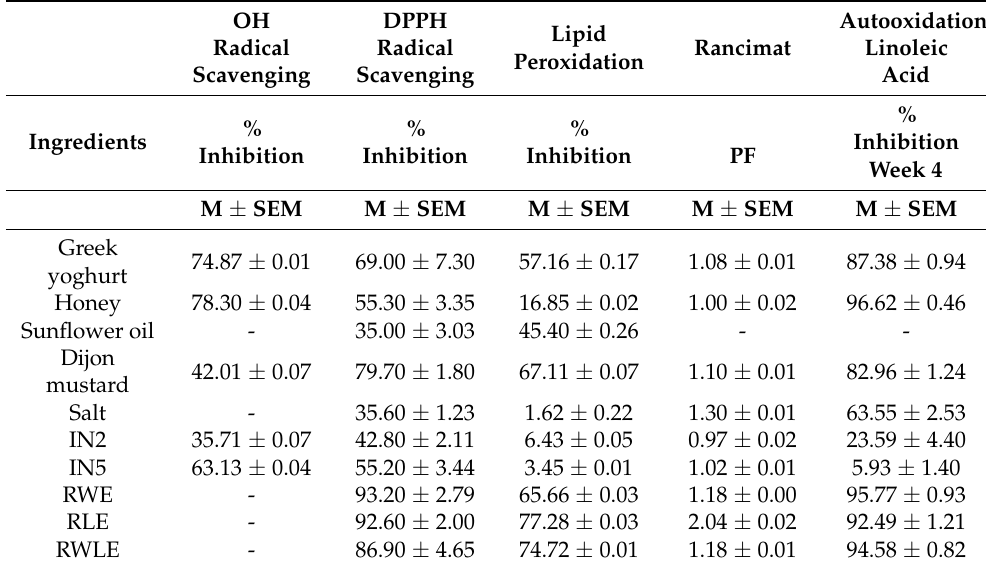
Table 6. Average ( n = 3) antioxidant activity separately evaluated in each yoghurt ingredient by different assays (hydroxyl radical scavenging, DPPH, lipid peroxidation, Rancimat test and inhibition of autooxidation linoleic